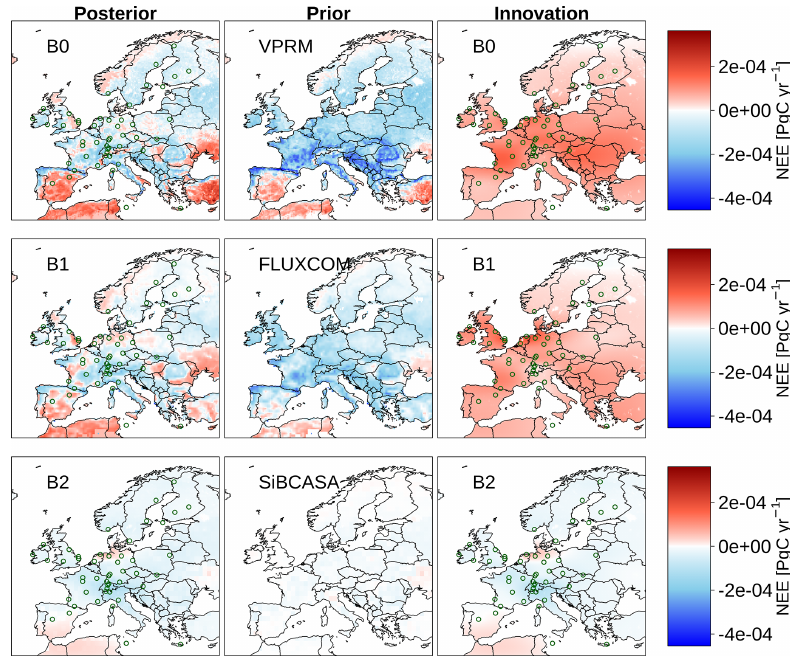
Figure 7. Posterior, prior, and innovation of fluxes (posterior – prior) averaged over the 2006–2018 period calculated from the biosphere ensemble of inversions (B0, B1, and B2). Green circles refer to observing